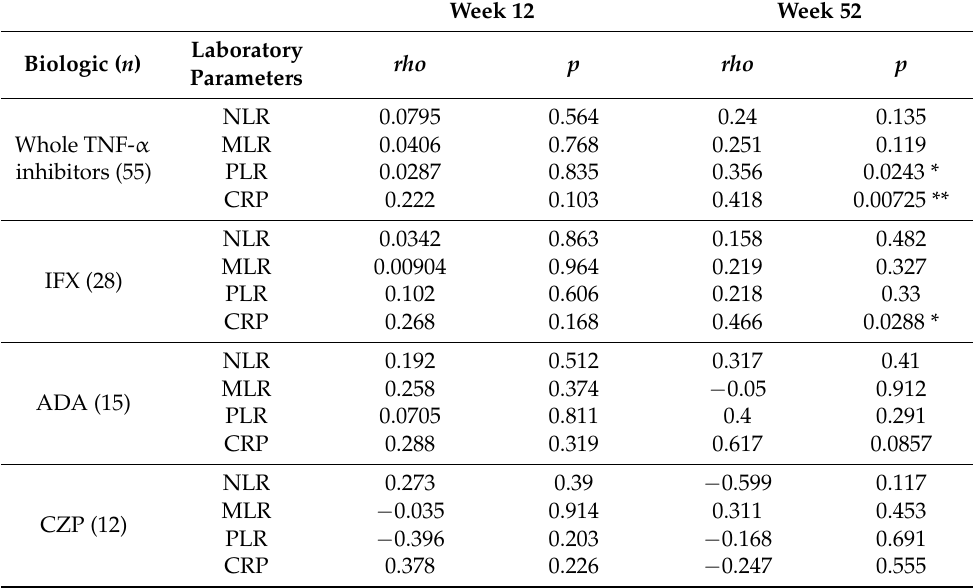
Table 4. Correlations between percentage reduction of psoriasis area and severity index versus those of neutrophil-to-lymphocyte ratio (NLR), monocyte-to-lymphocyte ratio (MLR), platelet-to- lymphocyte ratio (PLR) or C-reactive protein (CRP).